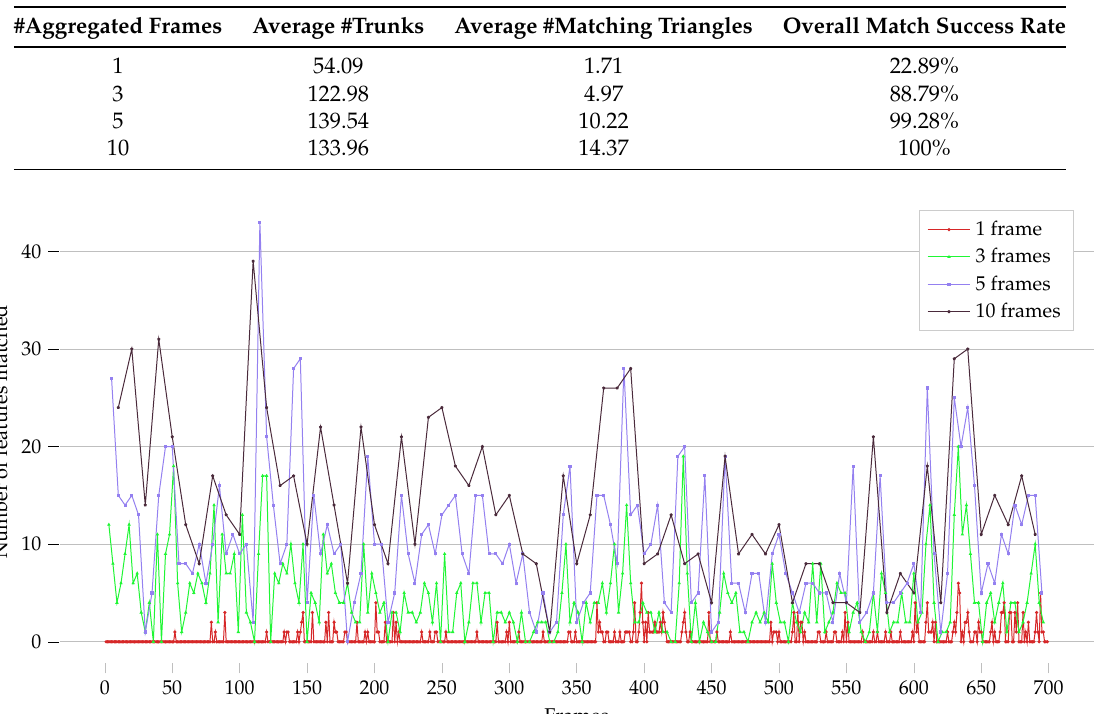
Table 1. Number of trunks detected and success match for different number of consecutive aggregated frames (average number of trunks matched per scan and total ratio of successful matches).